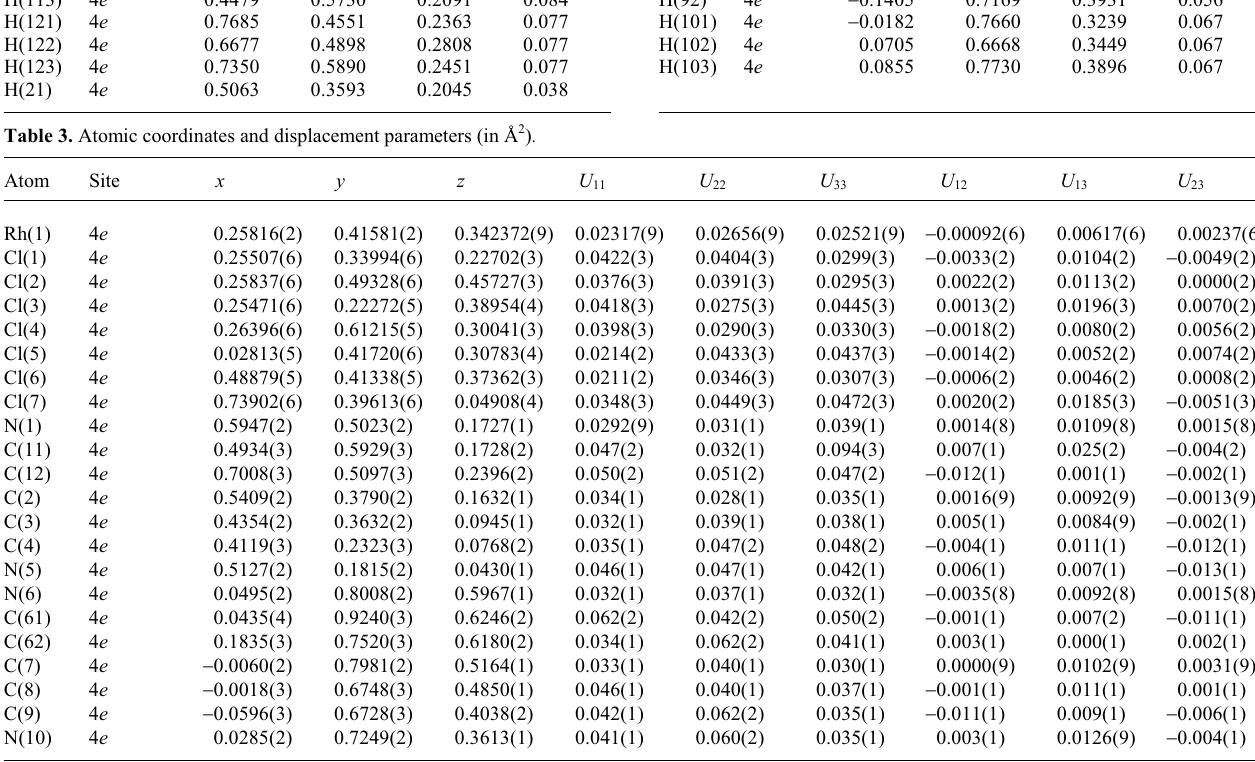
Table 3. Atomic coordinates and displacement parameters (in Å 2 )